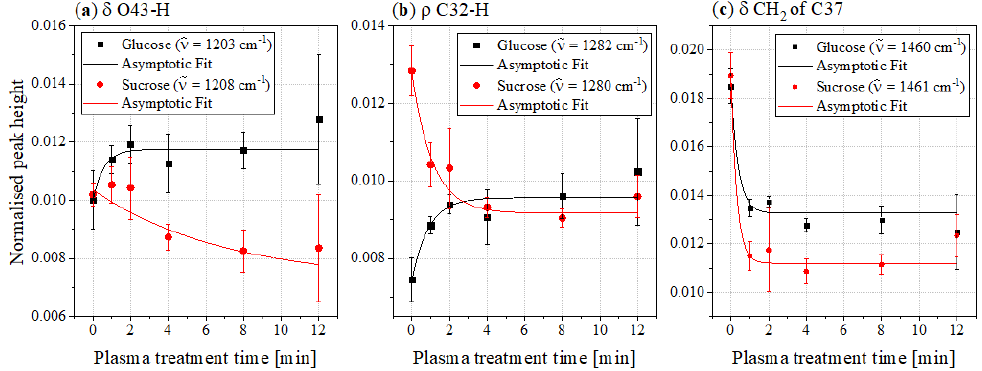
Figure 6. Peak heights of the ( a ) δ OH, ( b ) ρ CH and ( c ) δ CH 2 bands in the FTIR spectra of glucose (black) and sucrose (red) as a function of the plasma treatment